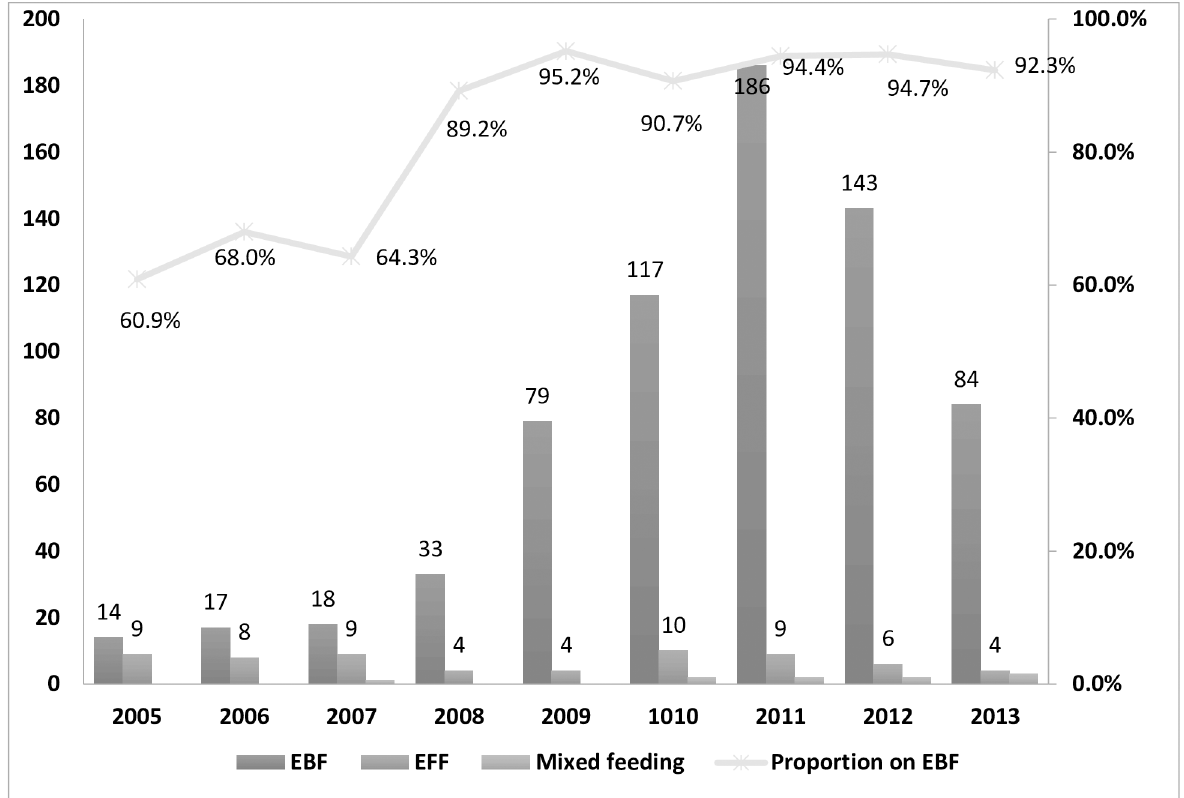
Fig 2. Patterns of infant feeding practices from 2005 to 2013 among babies with DNA PCR/HIV antibody tests in the MSG programme, Addis Ababa. NB: EBF stands for exclusive breast-feeding; EFF stands for exclusive formula feeding.